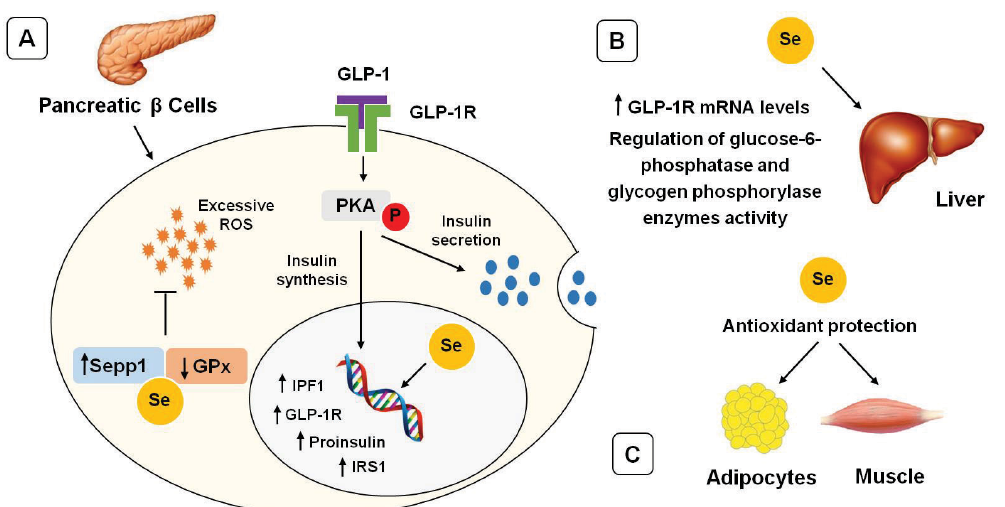
FIGURE 1 - The role of selenium in protection from insulin resistance. Overall, selenium appears to improve insulin resistance through three mechanisms. A) Firstly, in β-pancreatic cells, selenoproteins such as Sepp1 and Gpx exert antioxidant action, thereby inhibiting the excessive production of reactive oxygen species, which may impair the insulin signaling pathway. Moreover, selenium promotes the transcription and synthesis of proinsulin, insulin promoter factor 1, and GLP-1R. In the figure, we highlight the participation of the GLP-1-activated protein kinase A pathway in the regulation of insulin secretion and synthesis. B) Secondly, in the liver, selenium influences hepatic glucose production, by regulating glucose-6-phosphatase and glycogen phosphorylase enzymatic activity, and increasing GLP-1R expression. C) Thirdly, in peripheral organs, selenium improves insulin sensitivity due to its antioxidant action. GLP-1: glucagon-like peptide 1; GLP-1R: GLP-1 receptor; GPx: glutathione peroxidase; IPF1: insulin promoter factor 1; IRS-1: insulin receptor substrate 1; P: phosphorylation; PKA: protein kinase A; ROS: reactive oxygen